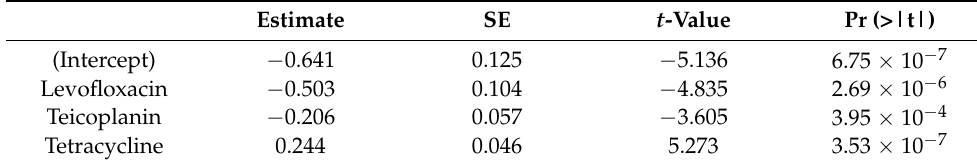
Table 1. Antibiotics with a coefficient significantly different from 0 in model